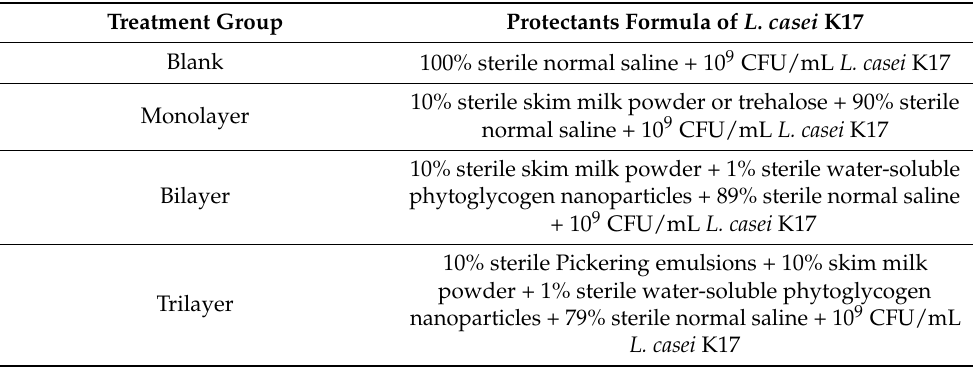
Table 1. The different processing methods of protectants for Lactobacillus casei